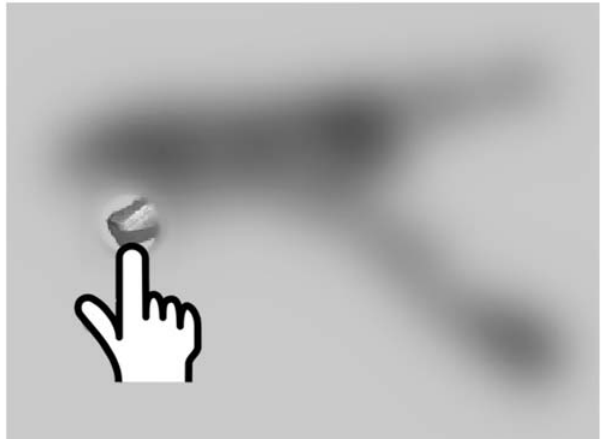
Figure 1. Viewing Window Illustration. The circular viewing window displays the underlying image in normal clarity, while the remainder of the image is heavily blurred.